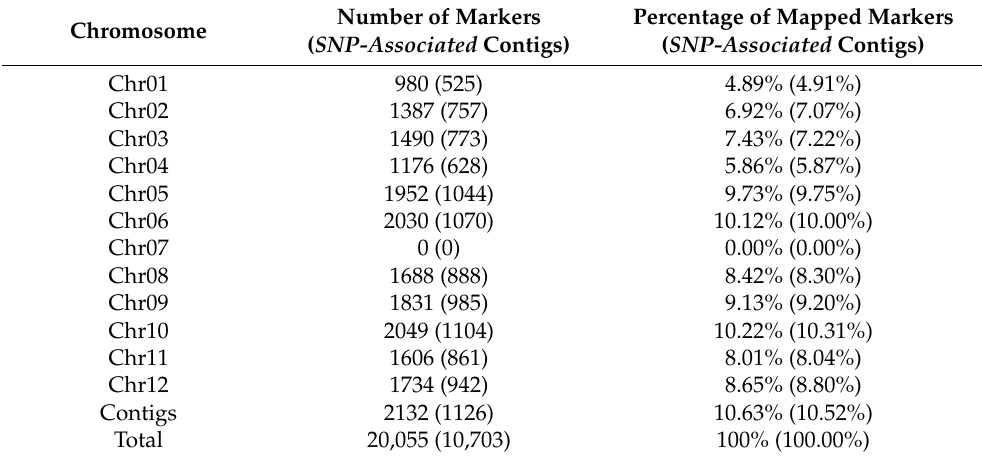
Table 3. The distribution of SNPs at rep6M5F05C4blastAnnot35bp across the Chinese pine reference genome in the twelve linkage groups and